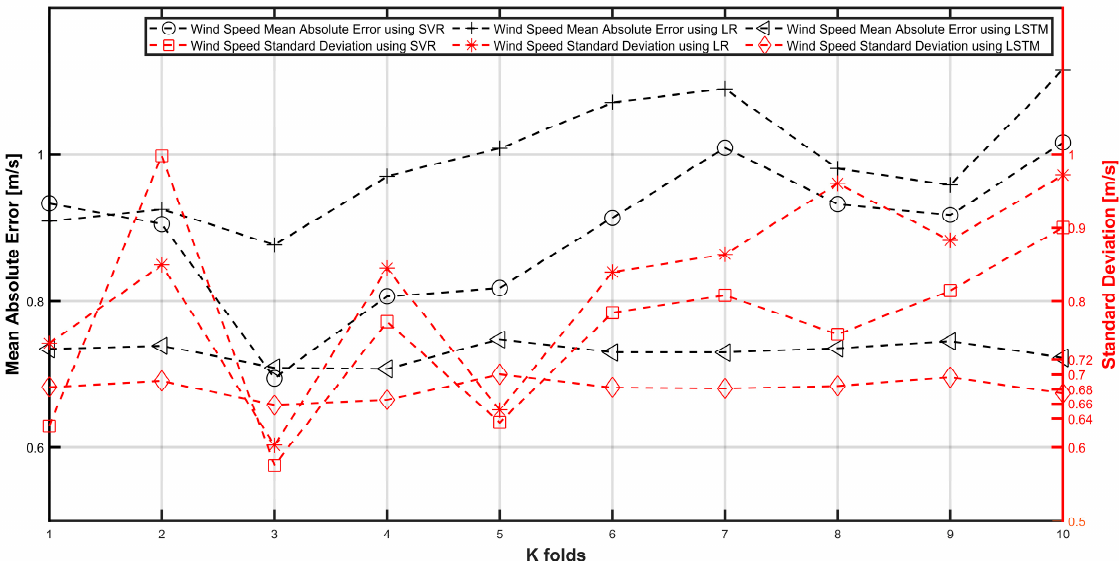
Figure 4. Wind speed variation in K folds.